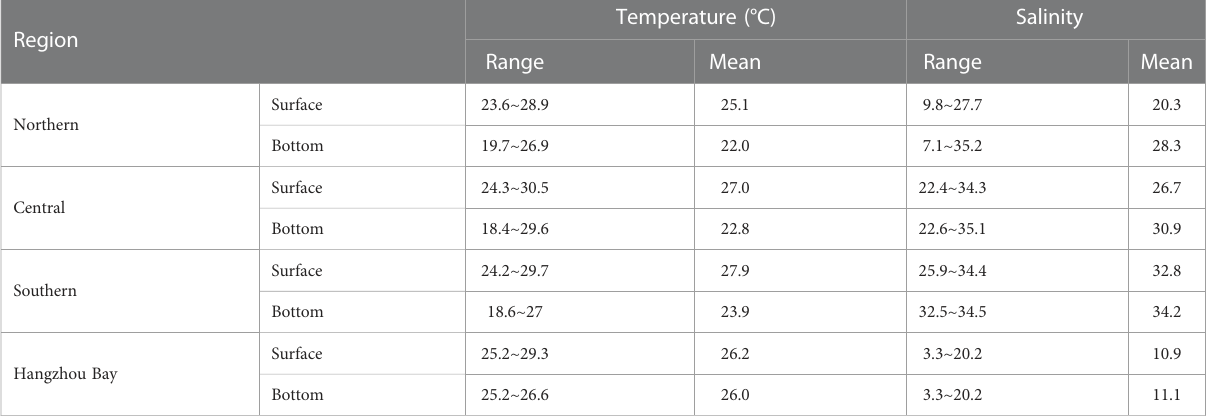
TABLE 2 Temperature and salinity variation in the Surface and bottom of Zhejiang coastal area.